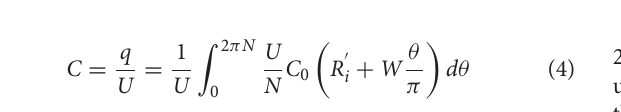
FIGURE 6 | Major two microwave structures involved in the sensor (A) loop probe and (B)